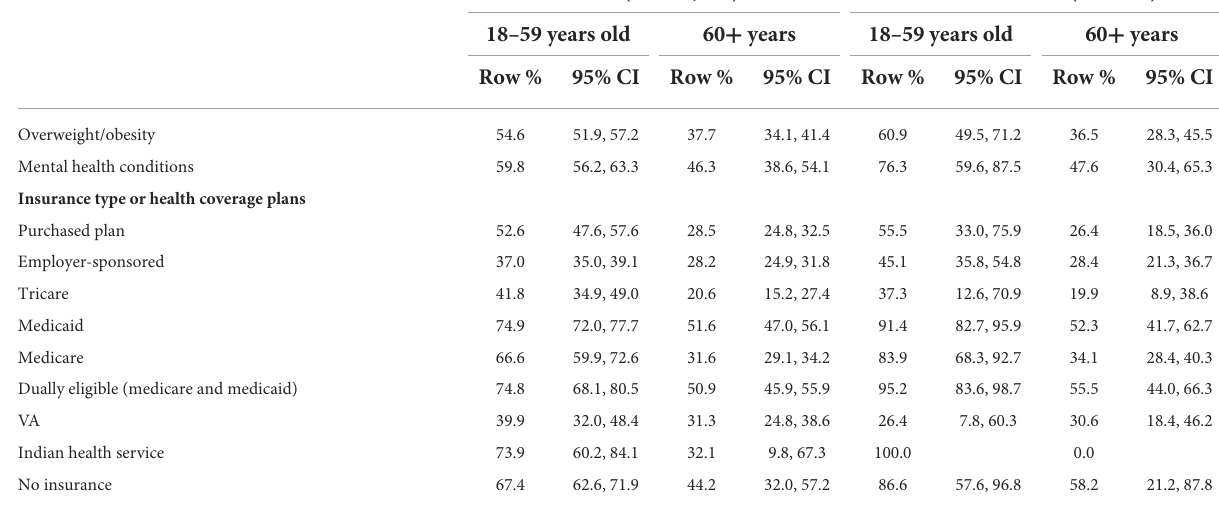
financial hardship compared to their counterparts. Among